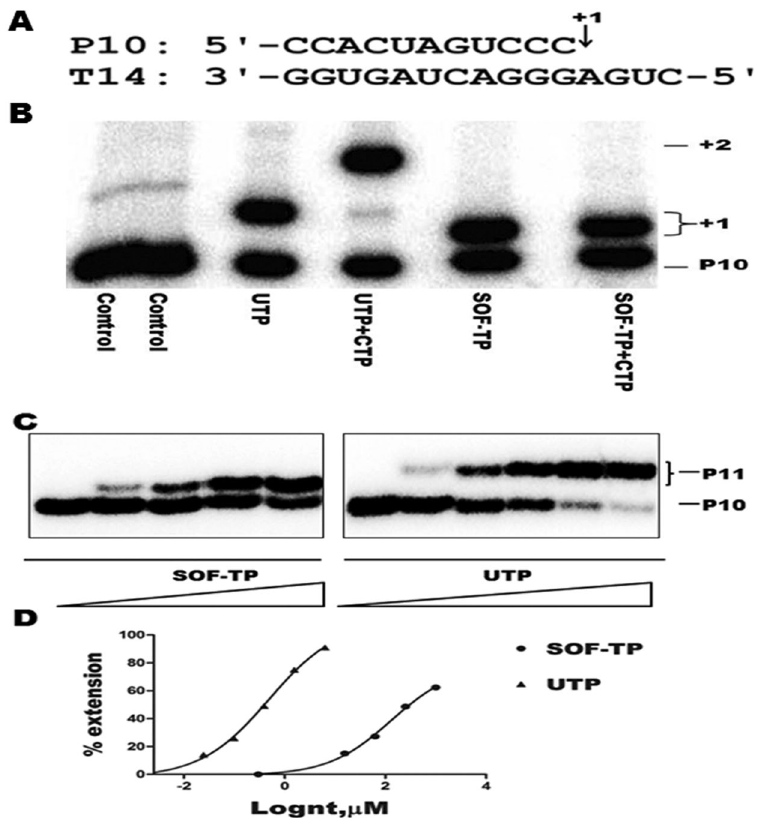
Figure 3. Comparison of incorporation efficiency of UTP and SOF-TP by DENV NS5. ( A ) Sequences of the RNA primer P10 and the RNA template T14 used in the primer extension assay. + 1 indicates the position of the first nucleotide to be incorporated. ( B ) Parallel comparisons of incorporation of natural UTP (5 µ M for 10 min) or nucleotide analogue SOF-TP (200 µ M for 50 min) into RNA and chain-termination by purified recombinant DENV NS5 were performed at 30 °C in a primer extension assay. + 1 and + 2 indicate the positions of the first and the next nucleotides to be incorporated. P10 indicates the position of the 5 ′ -end radiolabeled P10 primer. Control represents reaction without addition of nucleotide or nucleotide analogue as a negative control. Of note, the migration of extended primer after incorporation of SOF-TP was faster than that seen after incorporation of the natural substrate UTP. ( C ) Single nucleotide incorporation reactions were performed at 30 °C in a standard primer extension assay using RNA duplex P10/P11 and DENV NS5 in the presence of variable concentrations of natural nucleotide UTP or the nucleotide analogue SOF-TP. Reaction products were analyzed using denaturing polyacrylamide gel electrophoresis (20% acylamide, 7 M Urea) and by phosphorimaging. The positions of P10 and extended P11 are indicated on the right of the panels. ( D ) Quantitative analysis of UTP and SOF-TP incorporation in panel A. The incorporation efficiency was evaluated based on the extension of 5 ′ -end radiolabeled P10 to P11. The measured K 1/2 values, i.e., concentrations of nucleotides (nt) at which half of the total percentage of the P11 product was formed for UTP and SOF-TP were 0.4 μ M and 131 μ M,